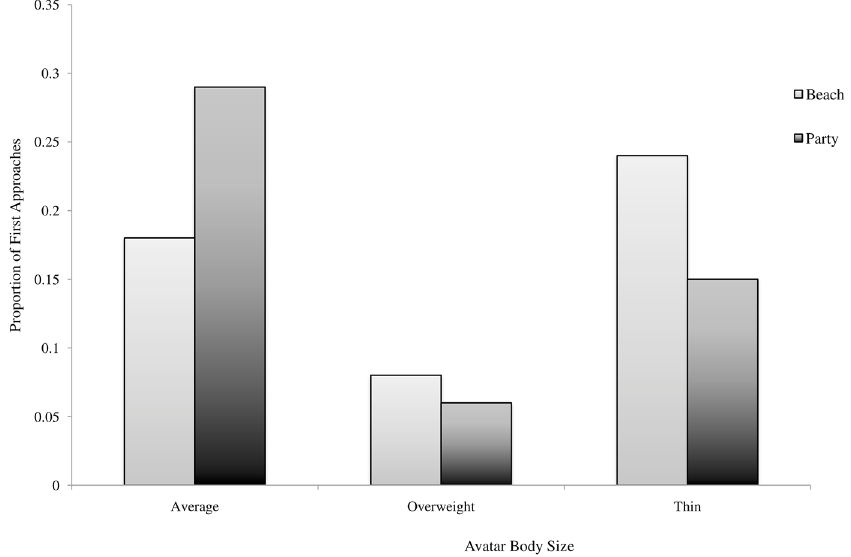
Fig 5. Proportion of avatars approached first by body size and populated